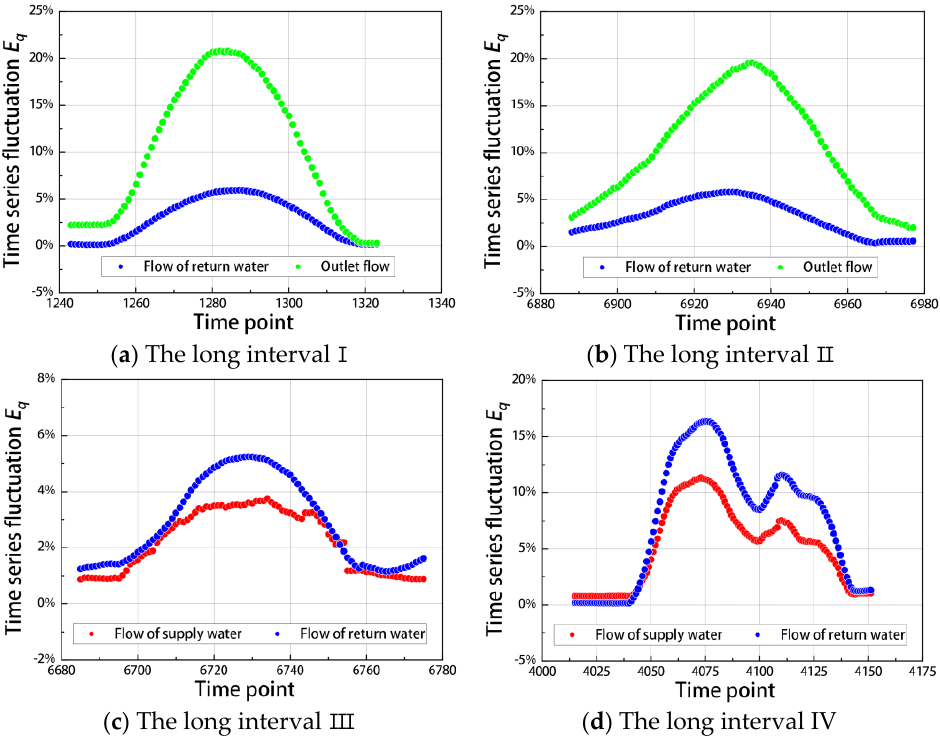
Figure 6. Time-series fluctuation values of step data points: ( a ) the long interval I ; ( b ) the long in- terval II ; ( c ) the long interval III ; ( d ) the long interval